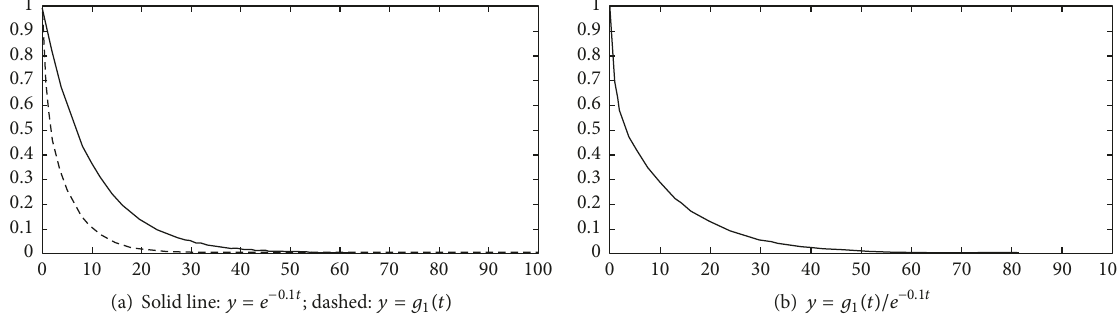
Figure 4: Exponential decay.